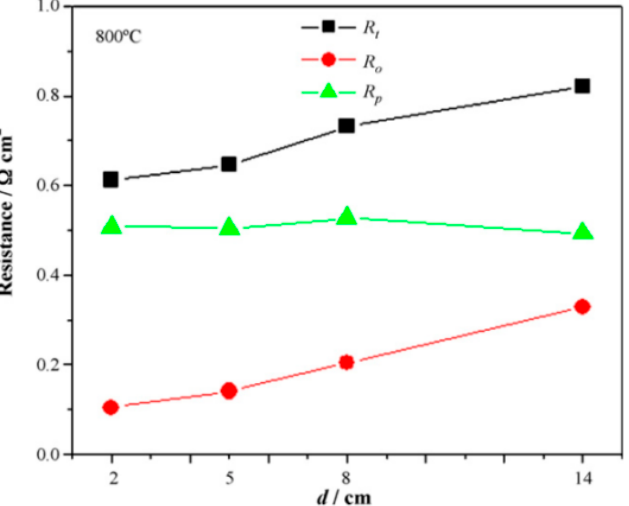
Figure 18. Distribution of R t , R o and R p of the four single cells. R t , the total cell resistance; R o , the ohmic resistance; R p , the interfacial polarization resistance; d, the distance between the cathode of the cell and the anode current collecting point [143].